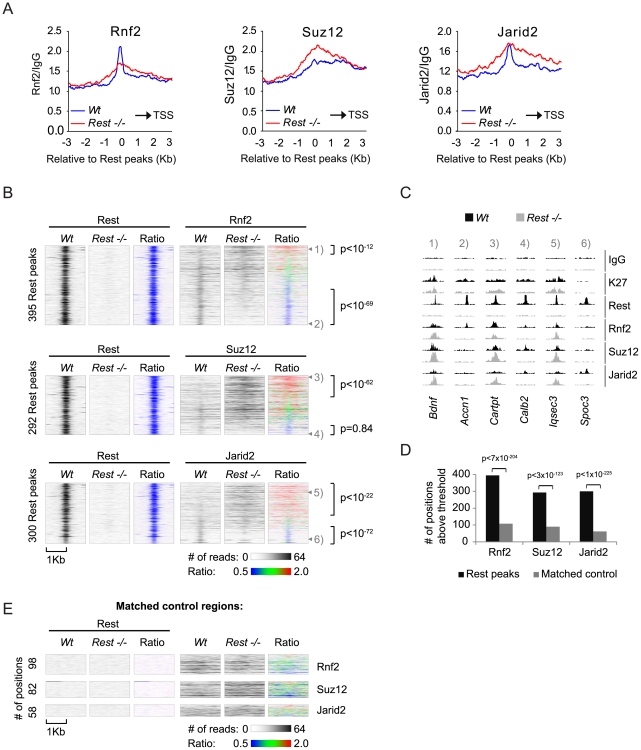
Occupancy of PRC1 and PRC2 at Rest peaks in Wt and Rest−/− mES cells.(A) Average ChIP-seq read counts in Wt control and Rest−/− mES cells, normalized to IgG controls for Rnf2, Suz12 and Jarid2 within 3 Kb of the 3,378 peaks identified for Rest in the Wt control cells. Black arrow indicates the direction of the nearest TSS. (B) Heat-maps showing Rnf2, Suz12 and Jarid2 occupancy in a 2 Kb window centered around individual Rest peaks identified in Wt control mES cells. The ratiometric heat-maps depict the part of the profiles that were increased, unaffected, or decreased in Rest−/− mES cells as red, green and blue, respectively. Out of the 3,378 Rest peak positions identified in the Wt control mES cells, positions with very low levels or no PcG (Rnf2, Suz12 and Jarid2) ChIP-seq signal in either Wt control or Rest−/− mES cells were filtered out (for thresholds and genomic peak positions see Table S3). The regions were sorted according to the fold change in PcG (Rnf2, Suz12 and Jarid2) signal between the Wt control and Rest−/− mES cells, within the Rest peaks. P-values were calculated by comparing the number of Rest binding sites with 1.5 fold increase or decrease to those expected from a population with similar distribution as the matched control using chi2-tests (C) ChIP-seq profiles for the positions marked 1 to 6 in Figure 4B as examples. Data from Wt and Rest−/− mES cells are shown in black and grey, respectively (K27 = H3K27Me3). (D) Diagram showing the number of Rest peaks and matched control regions (no Rest peaks) scored positive for Rnf2, Suz12 or Jarid2 signal. The filtering process described in the legend for Figure 4B. P-values compares binding sites scoring positive for PcG binding to those that scored positive by chance in the matched control regions using chi2-tests (E) Heat-maps of the matched control regions shown in 4D.